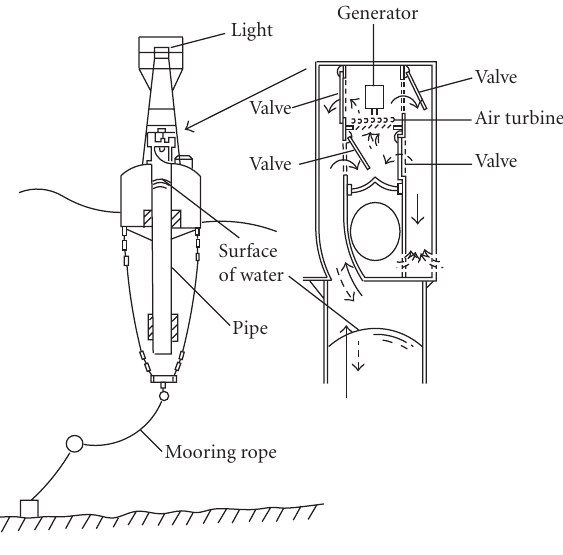
Figure 3: Navigation